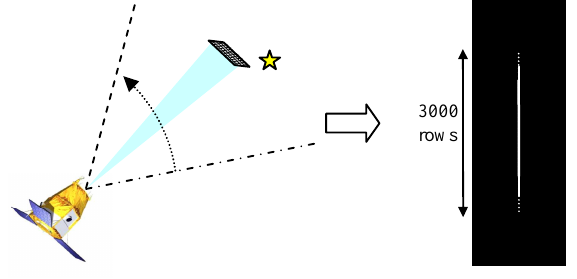
Figure 13 : Staracq acquisition principle and image extract The exploitation of such acquisitions is similar to that carried out on “steady images”. A line by line matching process can reveal disturbances along the lines due to a roll vibration. This method is very efficient and accurate. It has allowed the identification of disturbances of very low magnitude (until 10 -9 rad!) and to choose the most appropriate rate spin for the actuators wheels very rapidly.